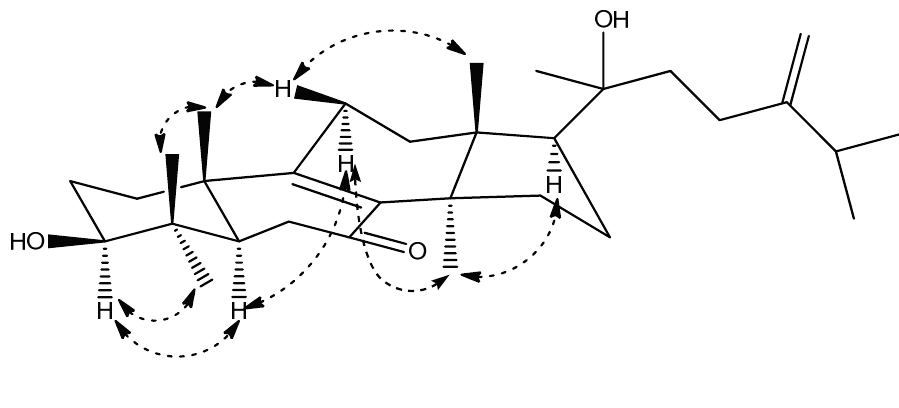
Figure 3. Key NOESY correlations of 1